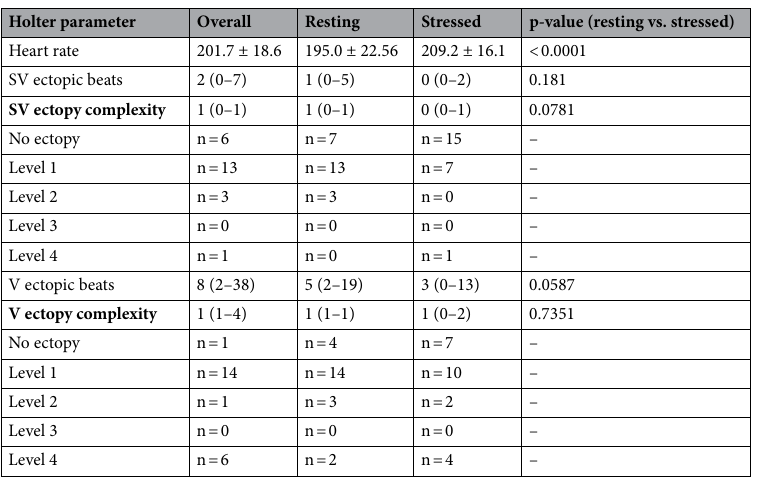
Table 2. Holter recording data for the 23 cats for both the entire recording and the portion of recordings before and after terbutaline administration. Data are displayed as mean ± SD if normally distributed or median (IQR) if